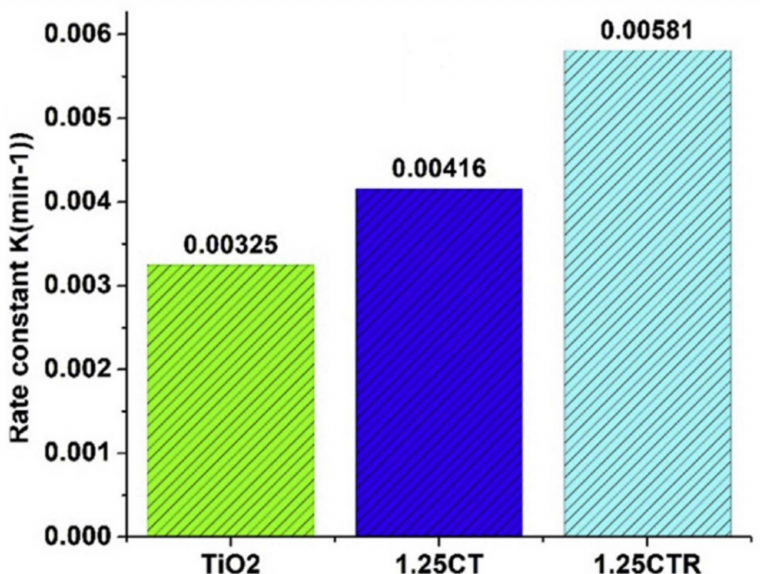
Figure 18. Effect of defects on rate constant with different ratios of Ce and Ti. Reprinted with permission from Elsevier, 19 December 2021 Ref.